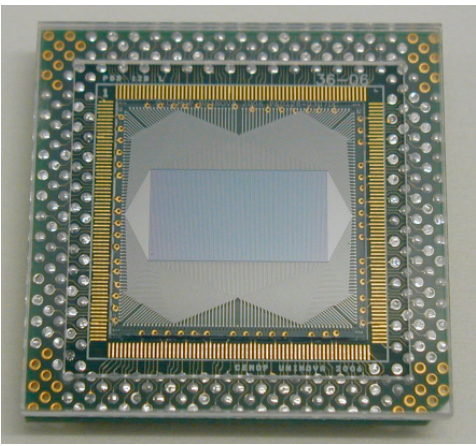
Figure 1. Amorphous silicon 128 PSD array glued and wire bonded to a suitable chip carrier.